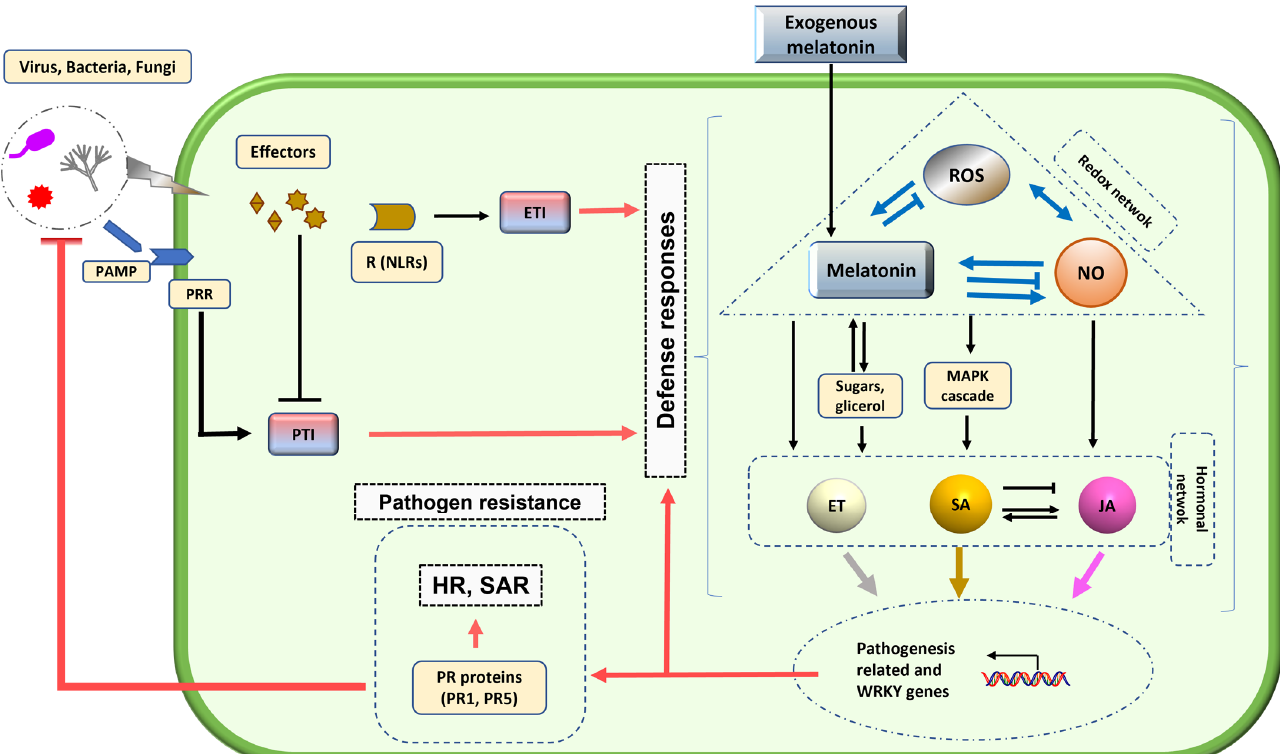
Figure 2. Model proposed for the interaction between plant pathogens (fungi, bacteria and virus) and defense responses mediated by melatonin. When a pathogen attacks plants, a defense system is activated: the pathogen-associated molecular patterns (PAMPs) of pathogens are recognized by the plant sensors called Pattern Recognition Receptors (PRRs) that trigger PTI (PAMP triggered immunity). On the other hand, effectors secreted by pathogens to facilitate infection (block PTI) are recognized by protein receptors (R) that contain nucleotide-binding domains and leucine-rich repeats (NLRs), triggering ETI (Effector-triggered immunity). This recognition activates a cascade of defense responses within the plant cell in which melatonin participates through the production and control of reactive oxygen species (ROS) and reactive nitrogen species (RNS), mainly nitric oxide (NO). At the same time both activate the melatonin endogenous biosynthesis, MAPK kinases cascade, sugars (cell wall reinforcement), defense hormones as ethylene (ET), salicylic acid (SA), jasmonic acid (JA), among others. All this activates the expression of WRKY and defense-related genes as plant resistance genes (PR1, PR5, and others), and consequently systemic acquired resistance (SAR) and the hypersensitive response (HR) are triggered. In this response process, treatment with exogenous melatonin plays an important role, helping to reinforce the plant’s defense, since it acts by increasing the endogenous level of melatonin in the plant cell. As a result, plants reinforced the melatonin-mediated protection against pathogens.